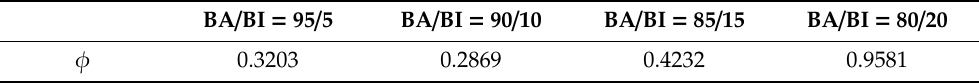
Table 6. Nucleation activity of PBABI copolyesters with di ff erent BA / BI contents.